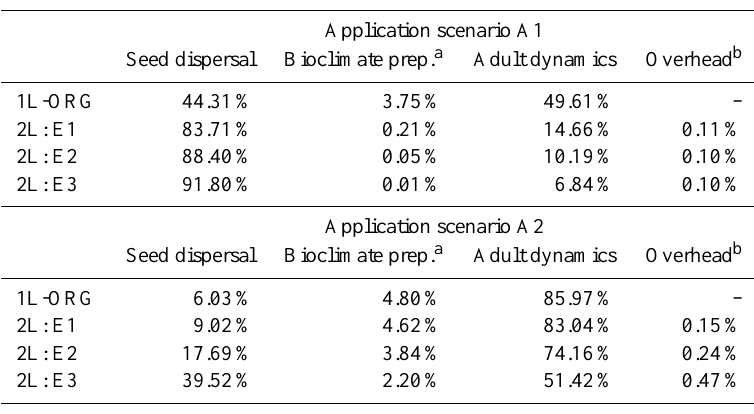
Table 6. Percentage of instructions executed for selected computation tasks. Shown are results from a callgrind (Weidendorfer, 2008) profiling of 1L-ORG simulations and of 2L simulations with all three sets of bioclimate types (E1–E3). The measured percentage of instructions executed for selected computation tasks is a performance measure comparable to the relative amount of CPU time spent with the tasks. Measures stem from simulations using the same pseudo-random number stream to extrapolate the bioclimate